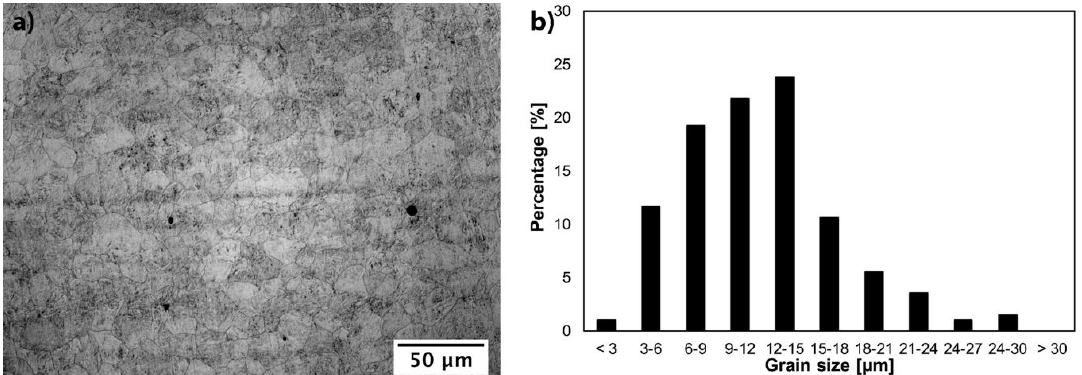
Figure 5. ( a ) Picric acid etched sample (300 ◦ C tempered) revealing the prior austenite grain boundaries (normal-to-rolling direction) and ( b ) the prior austenite grain size